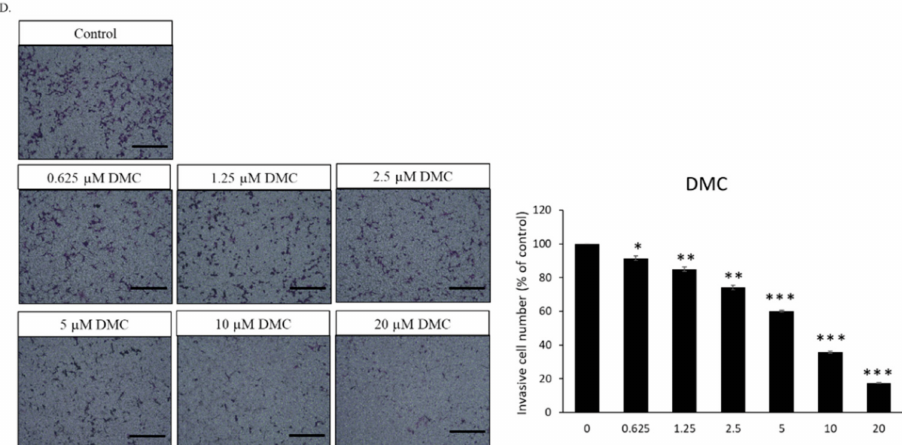
Figure 4. Inhibitory effects of curcuminoids (i.e., curcumin and DMC) on migration and invasion of endothelial cells. Transwell migration and Matrigel invasion assays were applied for analyzing the behavior of migration and invasion, respectively, of HUVECs administered with curcuminoids (i.e., curcumin and DMC). ( A ) The migration assay indicates that curcumin significantly inhibited the HUVECs migration. The left panel displays the image captured by a microscope at 100 × magnification. The right panel displays the statistical study. ( B ) Matrigel invasion assays showed that curcumin significantly inhibited the HUVECs invasion. The left panel shows the image acquired with a microscope at 100 × magnification. The right panel shows the statistical analysis. ( C ) The migration assay indicates that DMC significantly inhibited the HUVECs migration. The left panel shows the image acquired with a microscope at 100 × magnification. ( D ) The Matrigel invasion assay indicates that DMC significantly inhibited the HUVECs migration. The left panel displays the image taken with a microscope at 100 × magnification. * p < 0.05, ** p < 0.01, and *** p < 0.001 compared to the control group (treated with 10% FBS alone). All the scale bars indicate a length of 200 µ